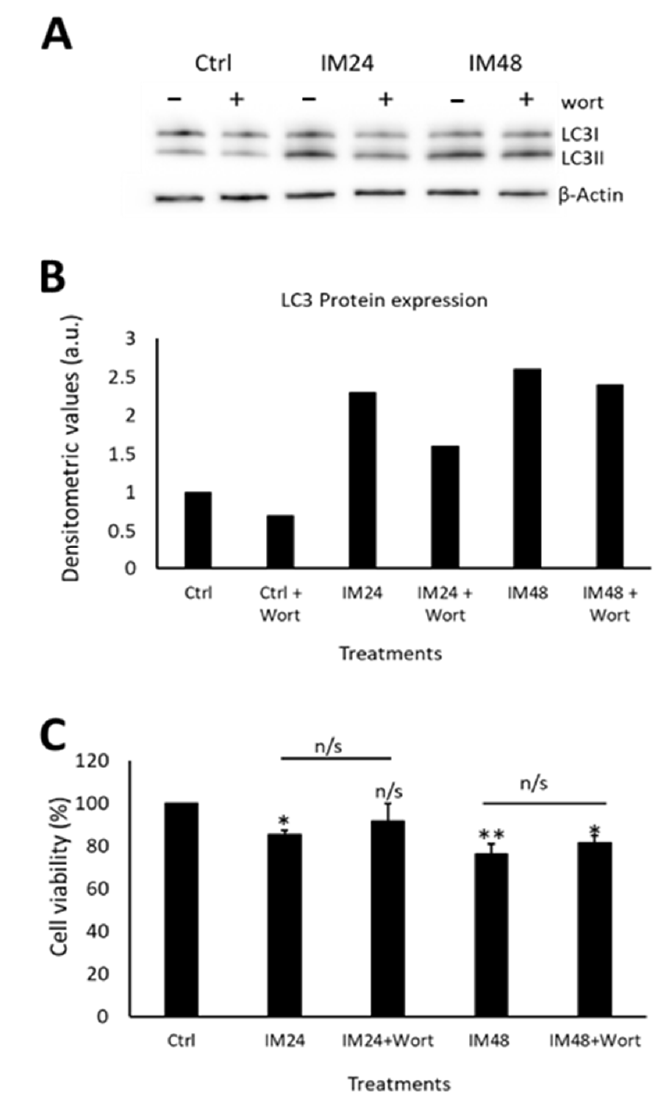
Figure 6. Autophagic flux only partially contributes to IM toxicity in hCPCs. ( A ) Western blot image and ( B ) densitometric values show LC3II expression after IM treatment for either 24 or 48 h, with/without wortmannin (wort) co-treatment, n = 1. ( C ) CPCs viability after treatment with or without IM and wortmannin treatment for 24 h. Data are mean ± SEM, n = 3; * p < 0.05 and ** p < 0.01 vs. control; n/s = not significant. Western blotting revealed a clear increase in total MLKL and phosphorylated MLKL after IM treatment (Figure 7A). Densitometry of phosphorylated MLKL confirmed this, with an 8.5 ± 2.5-fold increase after 10 µ M IM treatment compared to the control (Figure 7B). Necrostain-1 (nec-1) was used to inhibit the upstream necroptosis initiator RIP1; following nec-1 inhibition, cell viability was measured. Compared to the control, 10 µ M IM treatment for 24 h reduced the cell viability to 78.2 ± 2.5% ( p < 0.05), whereas 10 µ M IM treatment for 24 h co-treated with nec-1 reduced the cell viability to 88.7 ± 3.1% ( n = 3, p > 0.05) (Figure